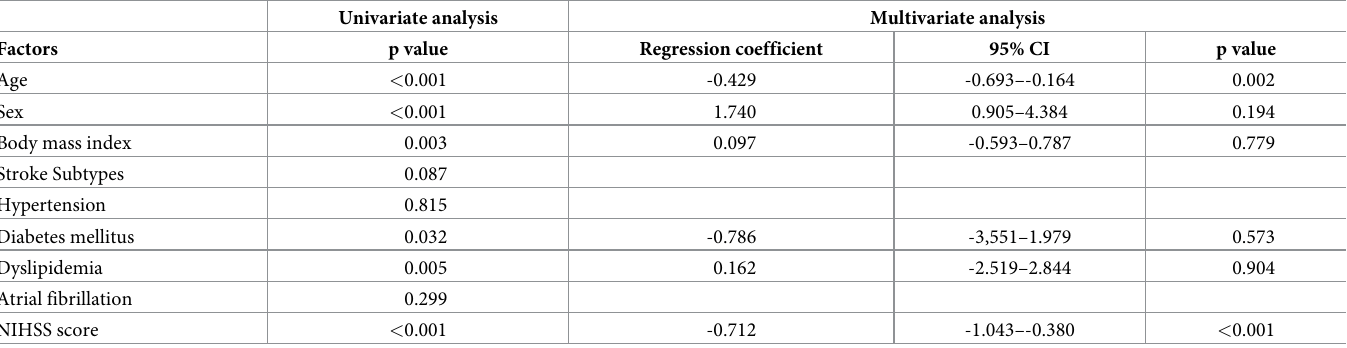
Table 2. Factors influencing tongue pressure.